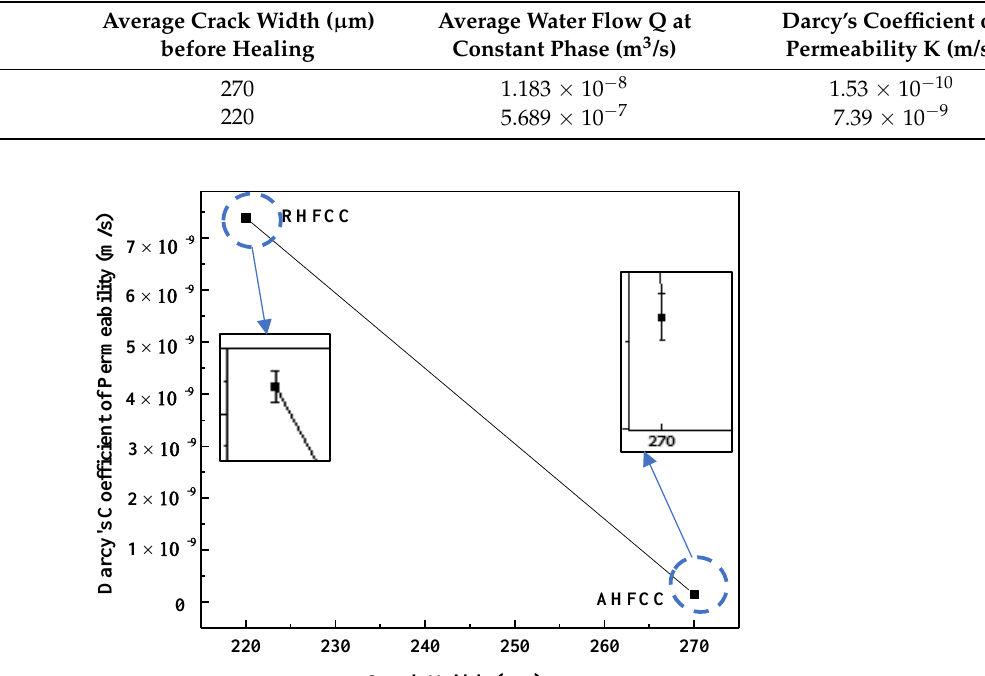
Figure 10. Water volume flow rate over time, ( a ) AHFCC and ( b ) RHFCC. Table 3. Permeability test results.